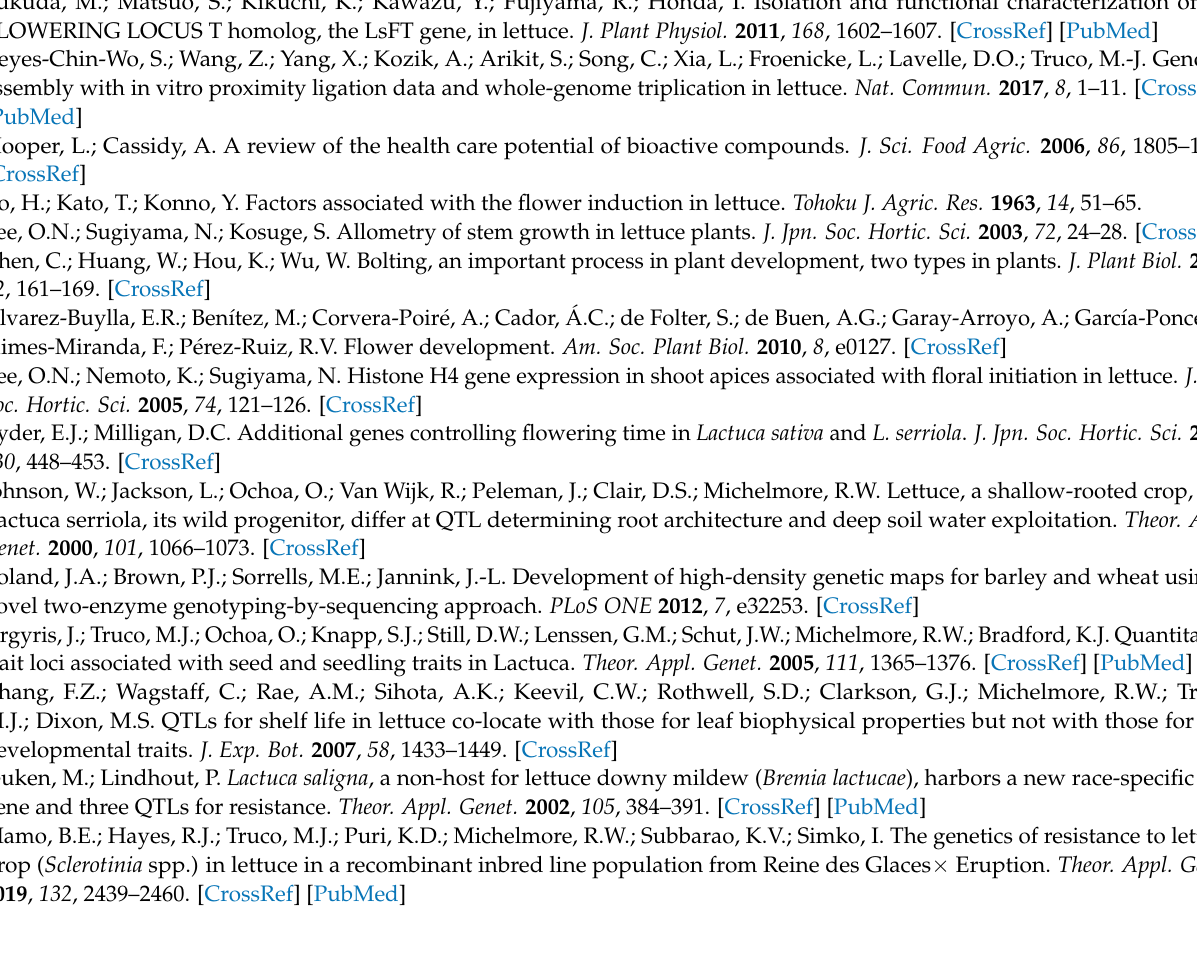
markers, Table S1: Genotypes of the genetic map constructed using GBS SNP